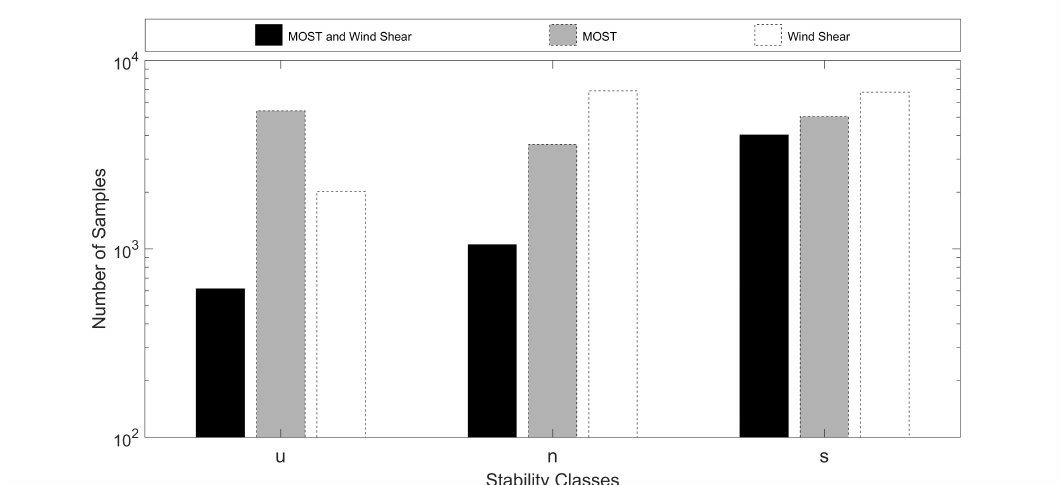
Figure 9. Comparison of the two different types of stability classification